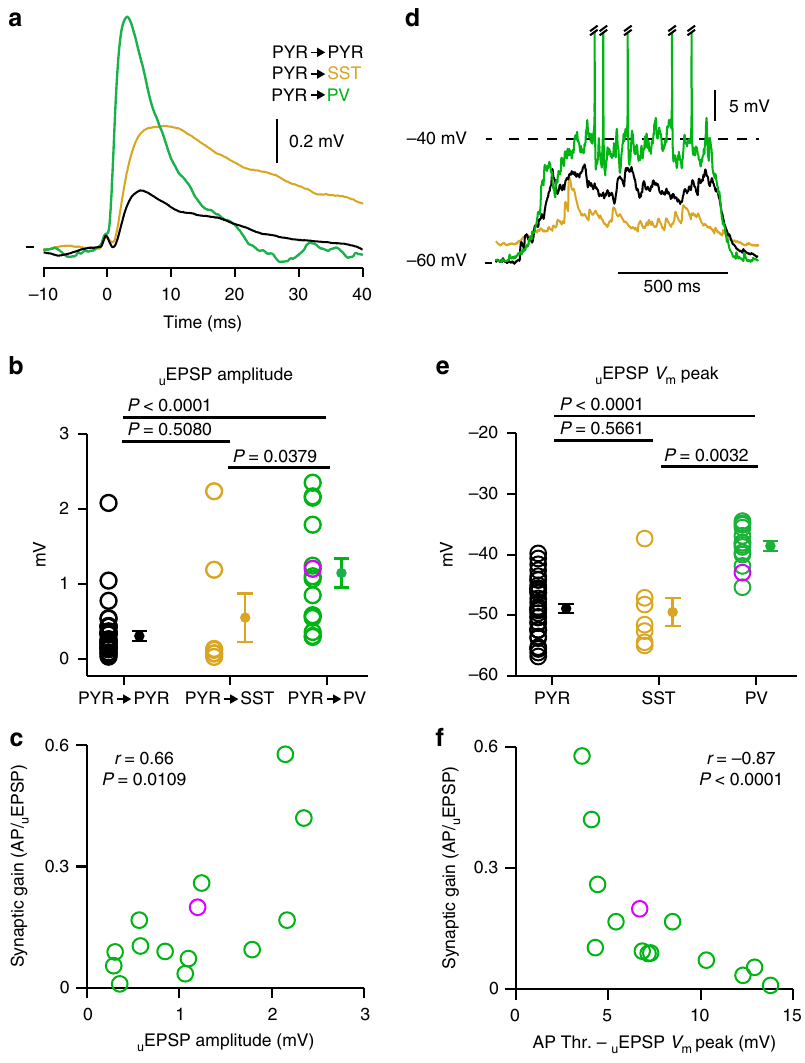
Fig. 4 Synaptic and membrane determinants of precisely timed u EPSP-evoked action potentials. a Population average u EPSPs during UPstate (black trace shows PYR to PYR neuron = 35 connections, orange trace shows PYR to SST neuron = 7 connections, green trace shows PYR to PV neuron = 14 connections). V m marks show PYR-PYR: − 51.7 mV, PYR-SST: − 50.5 mV, PYR-PV: − 45.7 mV. b The amplitude of mean u EPSP is larger in PV neurons than in PYR or SST neurons. Open circles represent single connection, purple circle shows connection in an awake mouse, fi lled circle with error bars shows mean ± s.e.m. c The synaptic gain of PV neurons is positively correlated with the mean u EPSP amplitude, open circles represent a single connection, purple shows awake data, statistical values were taken from a linear correlation between Ln(synaptic gain) and u EPSP amplitude. d Example V m traces shows larger amplitude and more depolarized UPstate in a PV neuron (green, APs truncated) than in a PYR neuron (black) or a SST neuron (orange). e The mean V fi cantly more depolarized in PV neurons than in SST or PYR neurons. f PV neuron synaptic gain is correlated with the difference u EPSP m peak is signi between AP threshold (AP Thr.) and the u EPSP V m peak of the postsynaptic response in a 5-ms window after the presynaptic AP, the linear correlation was performed between Ln(synaptic gain) and (AP Thr.- u EPSP V m